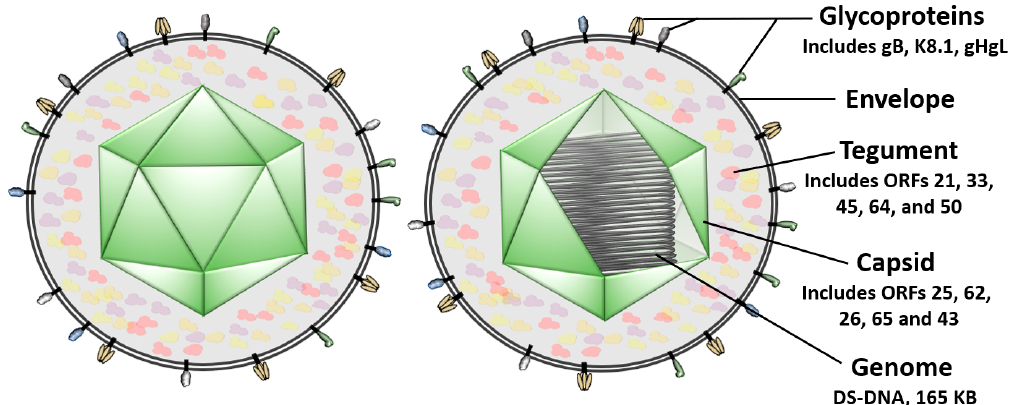
Figure 1. A diagrammatic representation of a Kaposi’s sarcoma-associated herpesvirus (KSHV)virion. Viral glycoproteins, the lipid envelope, tegument, capsid, and double-stranded DNA genome are indicated. On the right, the capsid is depicted with a cut-away section to reveal the double-stranded DNA genome inside. gB: glycoprotein-B; gHgL: glycoprotein-H and glycoprotein-L.